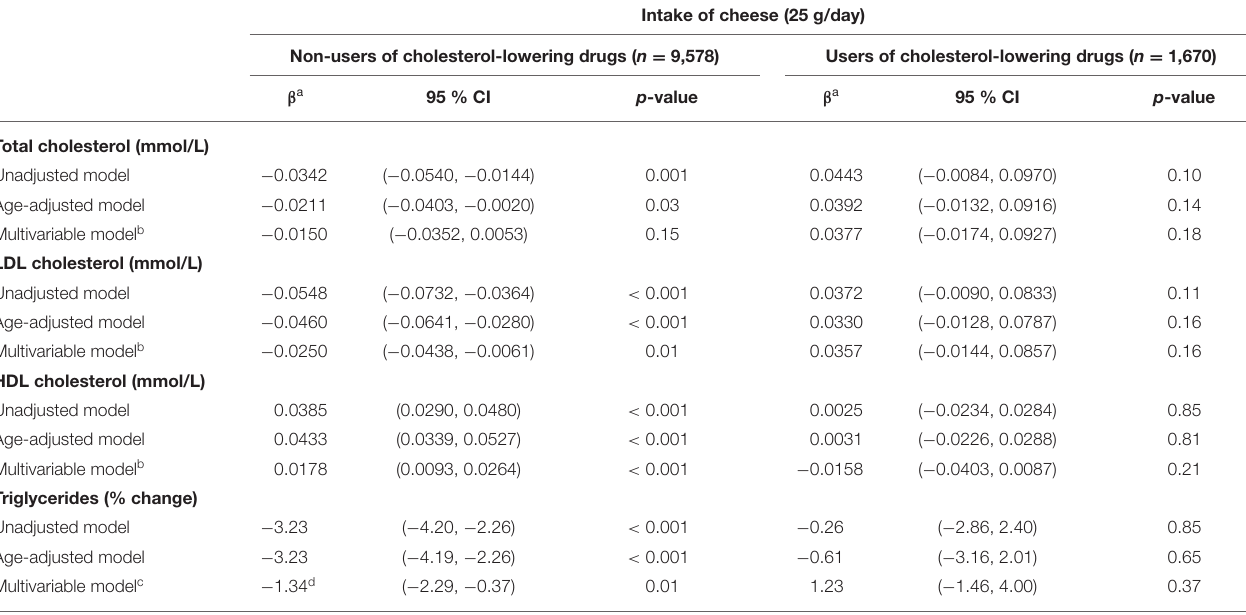
TABLE 5 | Linear regression coefficients for the associations between blood lipids and intake of cheese. The Tromsø Study: Tromsø7. Intake of cheese (25 g/day) Non-users of cholesterol-lowering drugs ( n = 9,578) Users of cholesterol-lowering drugs ( n =